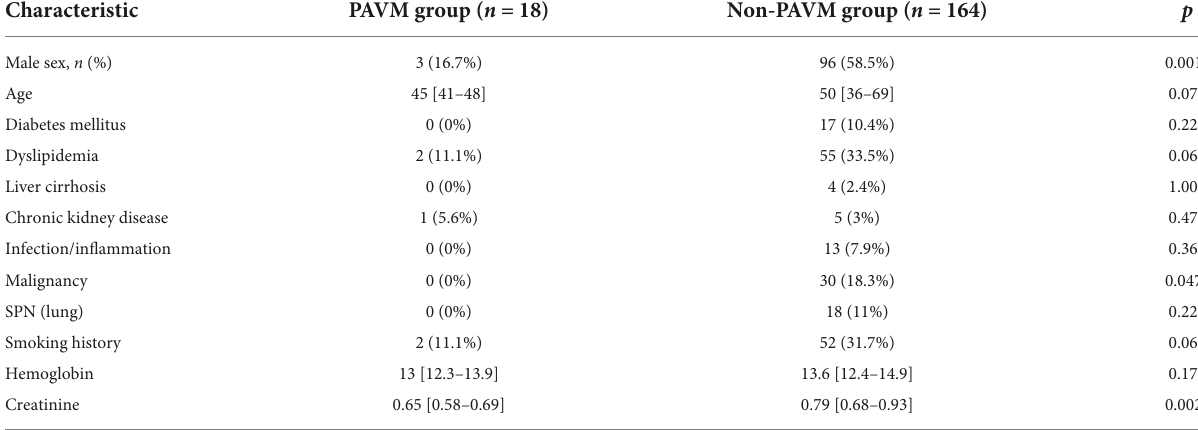
TABLE 1 Clinical characteristics and laboratory findings.